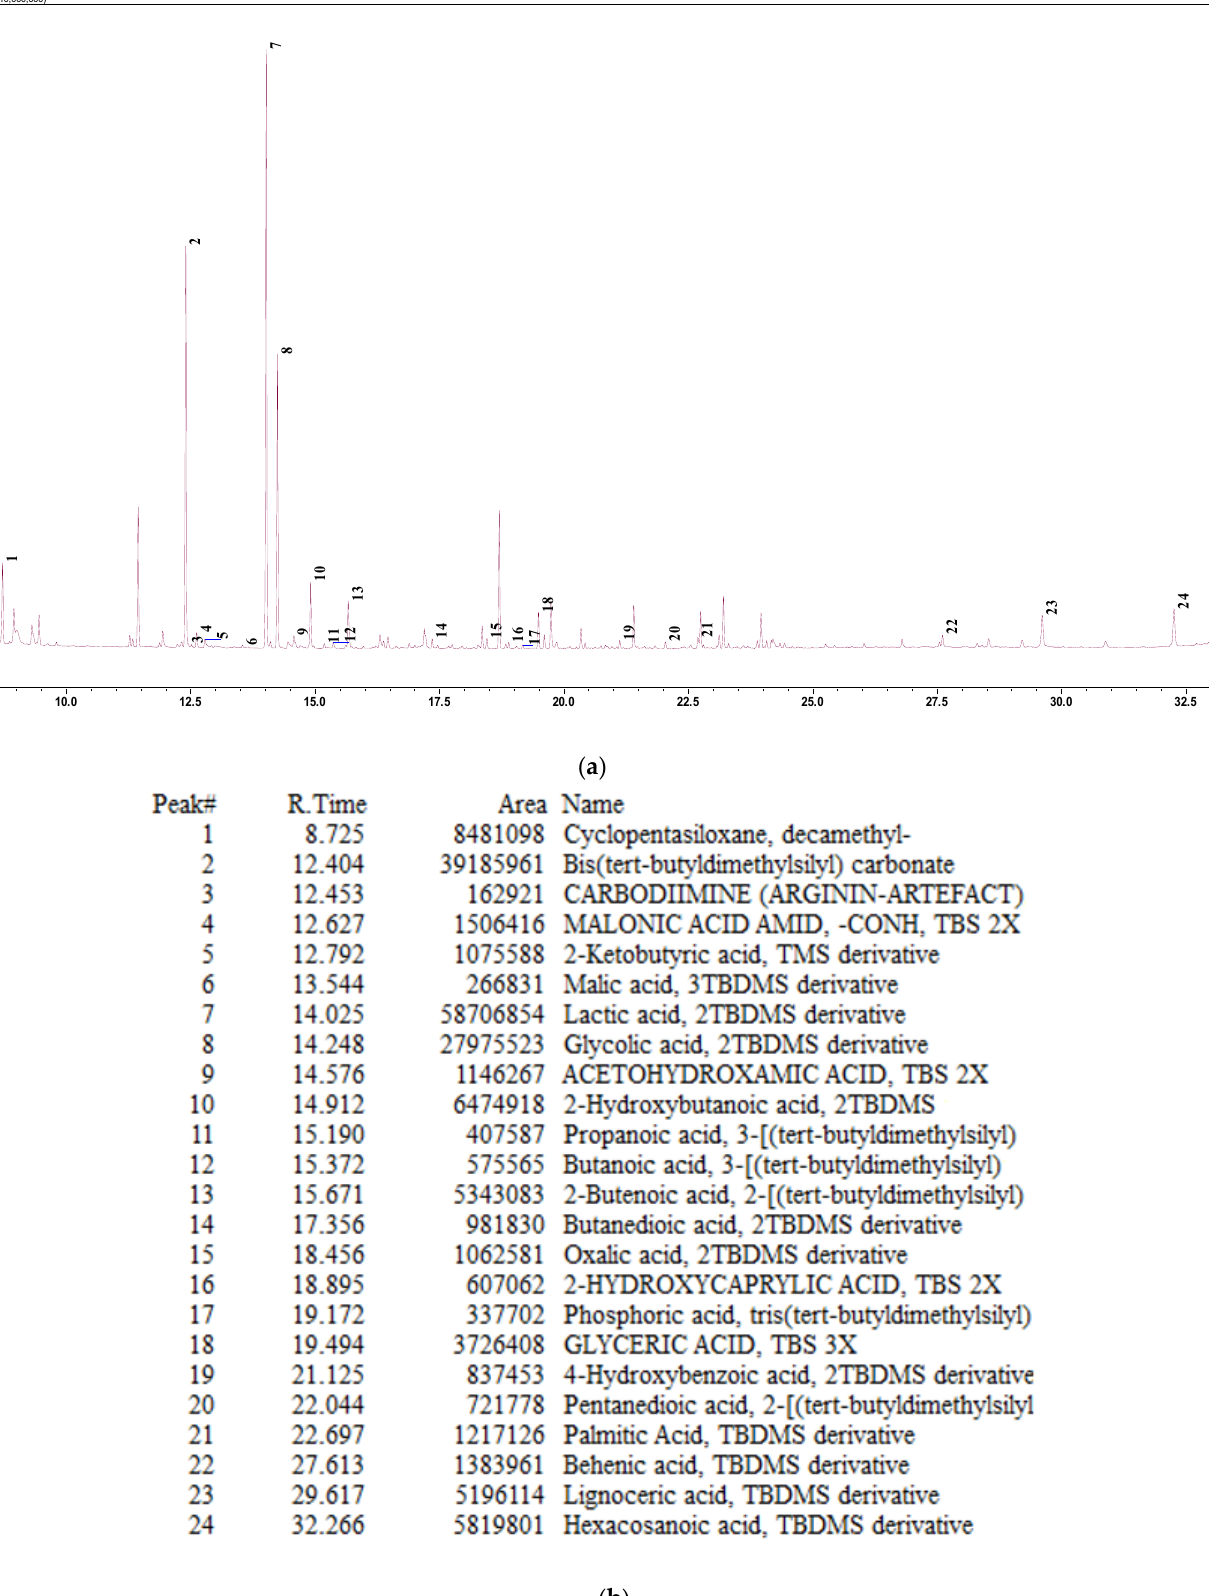
Figure 1. ( a ) GC-MS analysis chromatogram of the light peat alkaline extract after active maceration. ( b ) List of determined compounds of the GC-MS analysis chromatogram of the light peat alkaline extract after active maceration. A common list of the main organic compounds determined in different peat and sap- ropel extracts is shown in Table 1. Other compounds were in very low concentrations or just traces detected and are therefore not shown in the table. The highest mass fraction of the compounds was bis(tert-butyldimethylsilyl) carbonate; it was in all the tested peat extracts in variations from 6.90% to 25.68% but was not detected in sapropel extracts. The amount of lactic and glycolic acid derivatives was lowest in black peat, higher in brown peat, and highest in light peat extracts. Acetohydroxamic acid was determined in all peat and sapropel extracts, but the highest amount, 8.10%, was in sapropel after active macer- ation ( p < 0.05). Oxalic acid derivative and glyceric acid were determined in almost all extracts and varied very similarly in small quantities. It was interesting to note that lig- noceric and hexacosanoic acid derivatives were found only in the peat samples after active maceration, while they were not detected in samples after ultrasound extraction. Comparing two extraction methods, it was determined that active maceration was more efficient in yielding higher amounts of organic compounds. Total organic com- pound distribution using AME was higher than that using USE—in black peat extracts, 2.6 times; in brown peat extracts, 2.4 times; in light peat extracts, 1.4 times; and in sapropel extracts, 2 times ( p < 0.05).